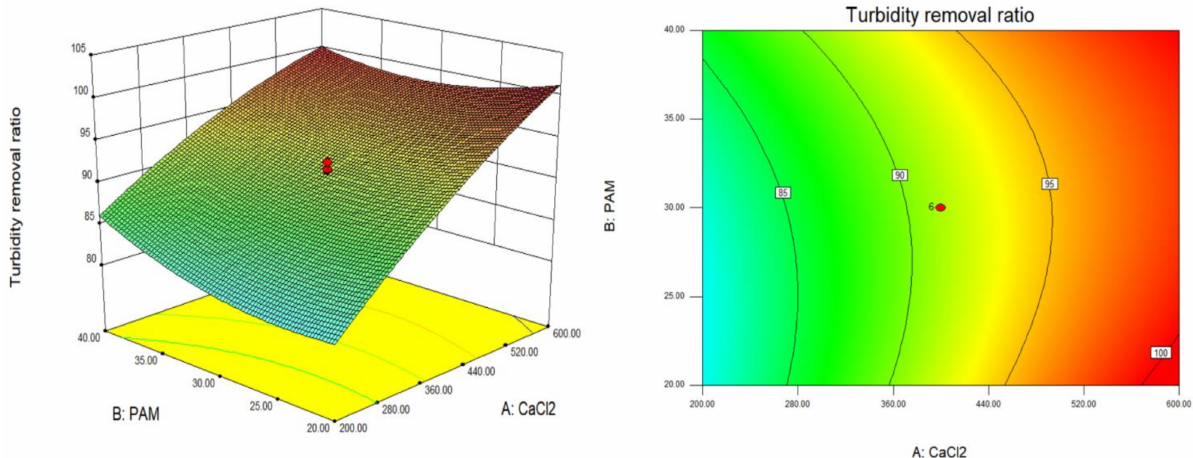
Figure 10. ( left ) Response surface of the turbidity removal ratio interacted by CaCl 2 dosage and PAM dosage. ( right ) Contour map of the turbidity removal ratio interacted by CaCl 2 dosage and PAM